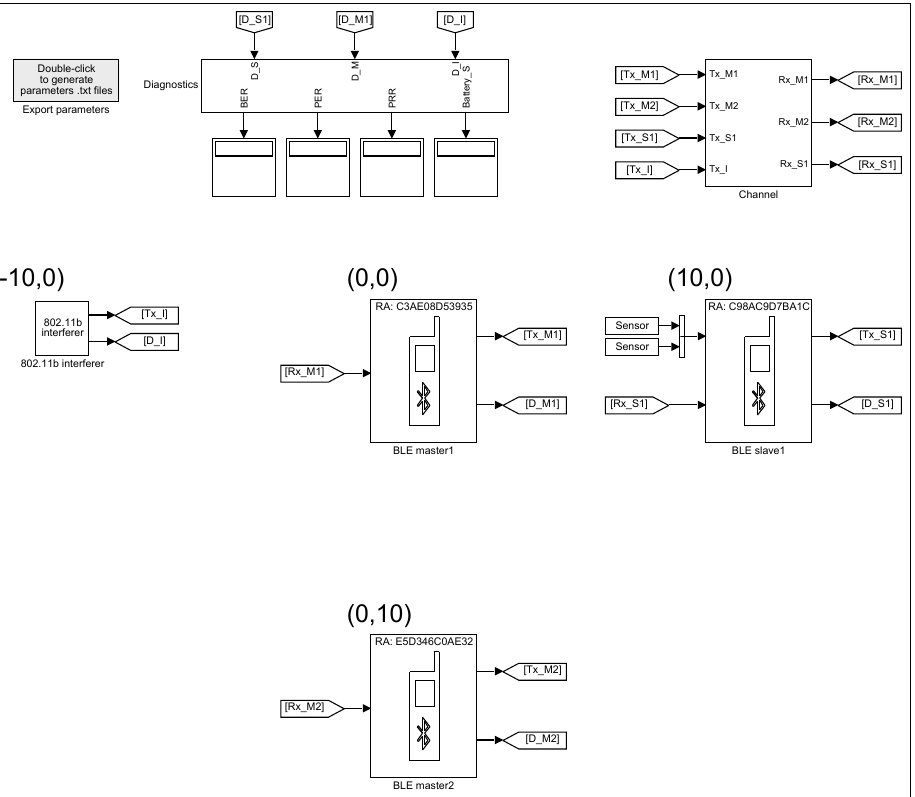
Figure 16. The model M 2S1 consisting of two master devices (in one slave mode), one slave and the interferer with their top left corners located at the coordinates (in meters) (0, 0), (0, 10), (10, 0) and ( − 10, 0),